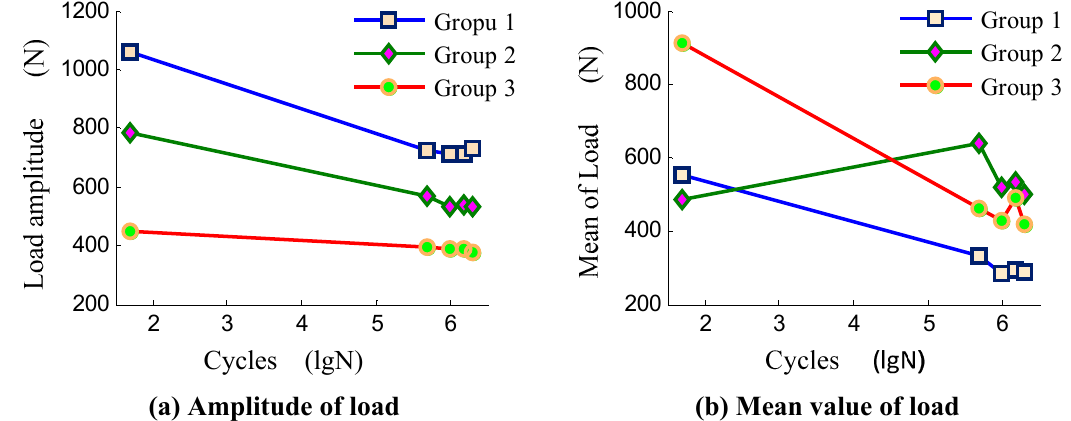
Figure 5. The change in cyclic force exerted during the displacement-controlled fatigue testing process.